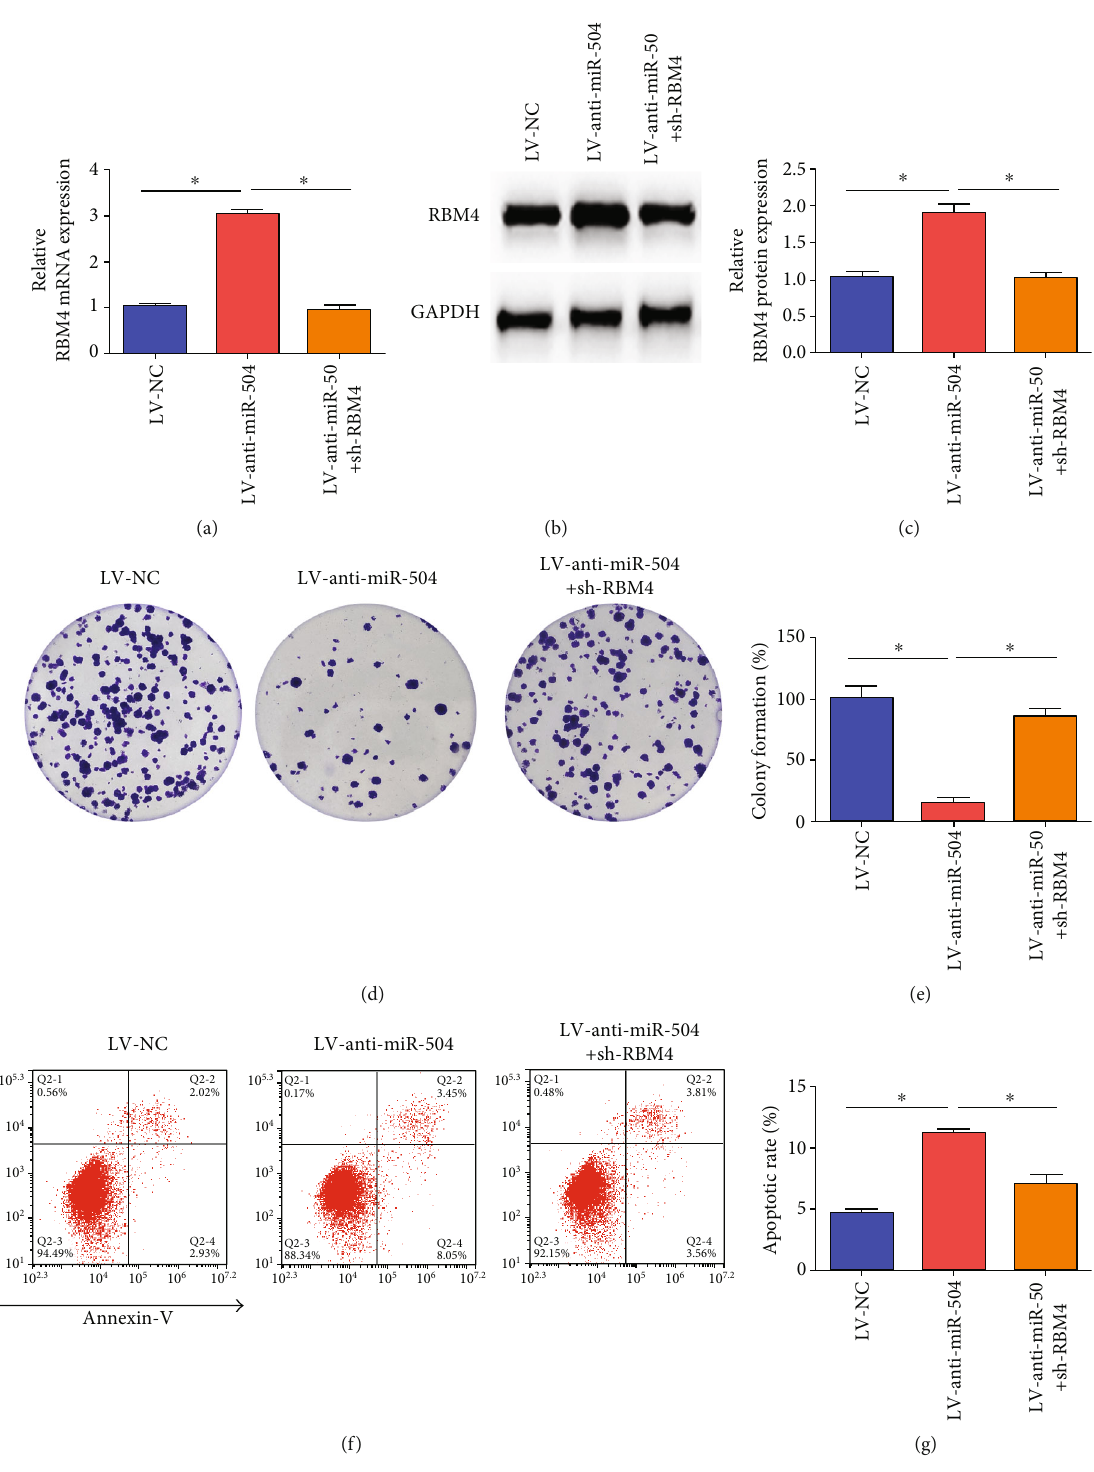
Figure 4: miR-504 promoted the growth of SGC-7901 cells by downregulation RBM4. (a) Relative expression of RBM4 mRNA in each group. (b, c) The expression of RBM4 protein in each group. (d, e) Colony formation of SGC-7901 cells in each group. (f, g) Measurement of the apoptosis rates of SGC-7901 cells by fl ow cytometry. The Q2-4 and Q2-2 gates were calculated. ∗ P < 0 : 05 lated with the expression of RBM4 ( r = − 0 : 444 , P < 0 : 05 , Figure 1(d)). The dysregulation of miR-504 and RBM4 in gastric cancer cells indicated the important role of miR-504 and RBM4 in the development of gastric cancer.